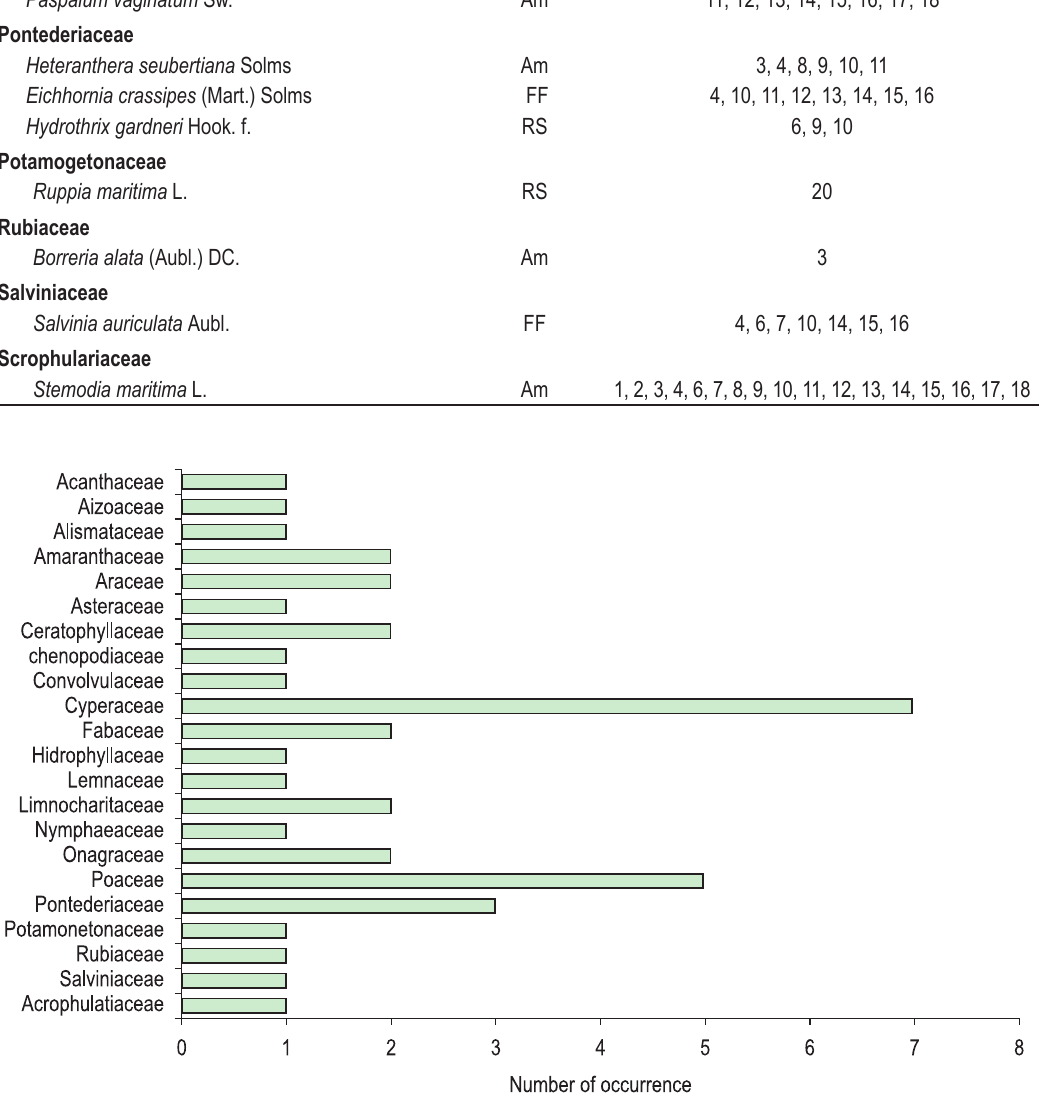
Figure 2. Number of occurrence of species, per family, in 20 sampling stations of the basin of the Apodi/Mossoró River, RN, Northeast